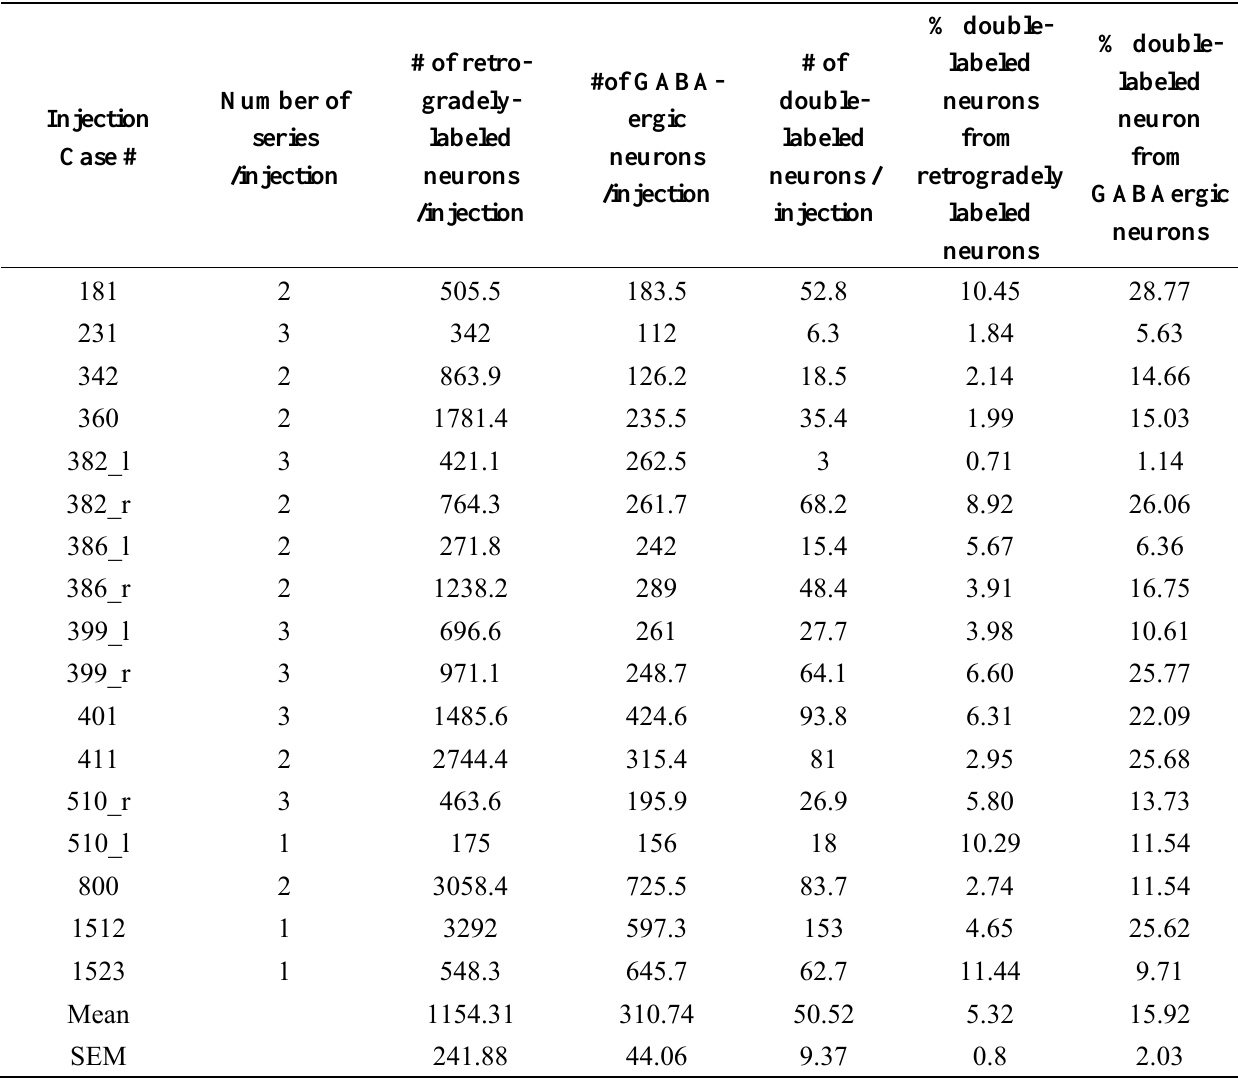
Table 3. Average of counts of retrogradely-labeled, GABAergic, and double-labeled neurons and the percentages of GABAergic projection neurons from either population. The number of series/injection is derived from Table 1, because in some animals three series were used and in others only one. At least three sections were analyzed for each case. In cases where more than one series (most often three sections/series; see Table 1) was analyzed for one injection case, the mean of each series was averaged to obtain the mean of the